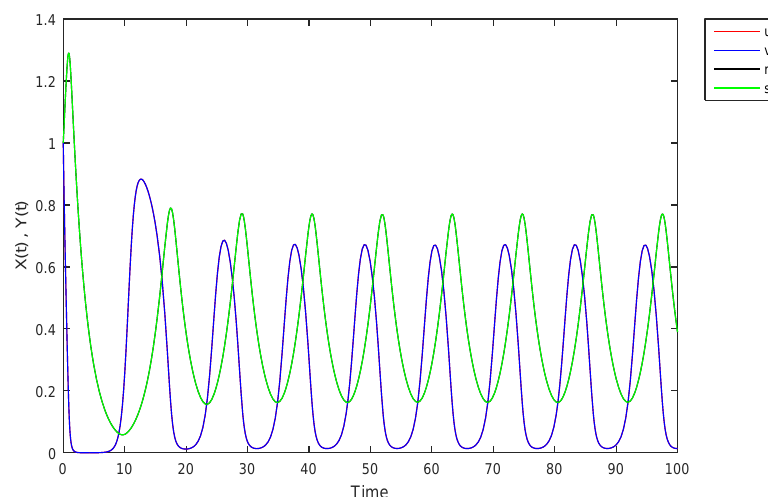
Figure 2. The solution of (4) at α = 0.5.